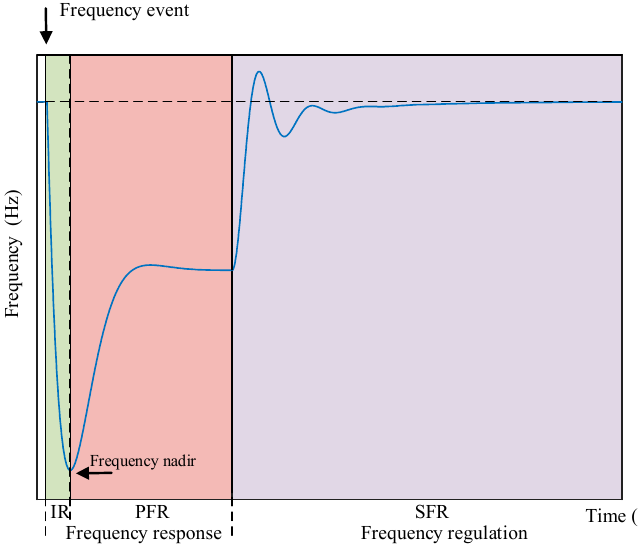
Figure 10. Multiple temporal frequency control under VSG algorithm.